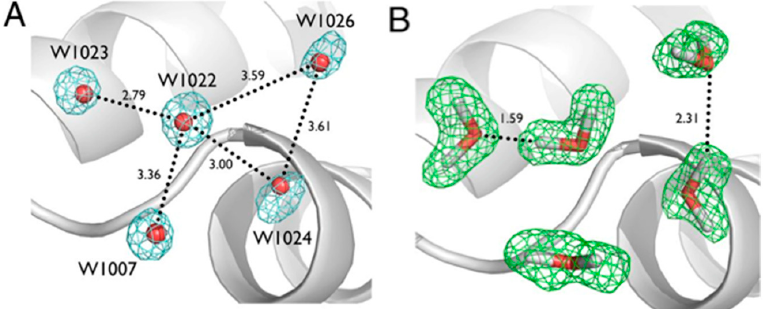
Figure 2. Ultra-high resolution X-ray and neutron crystallographic studies of H/D exchanged crambin, showing ( A ) details of possible H bonds between five ordered water molecules in crambin as observed in the X-ray crystal structure; and ( B ) observed H bonds between water molecules as seen in the neutron crystal structure. Figure reproduced from [20].